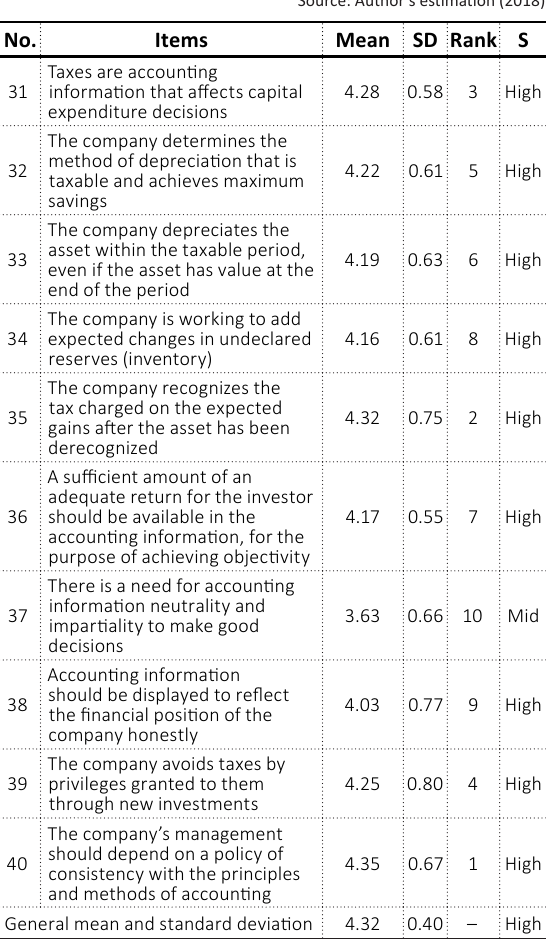
Table 14. Items related the to fourth sub-hypothesis